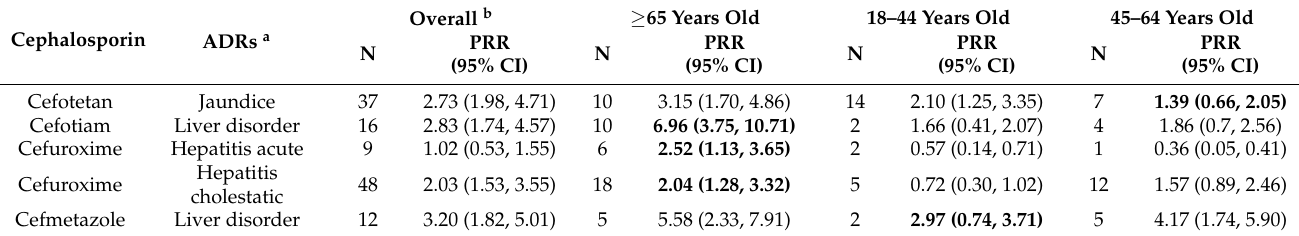
Table 3. Disproportionality for hepatobiliary adverse drug reactions associated with the use of cephalosporins by age